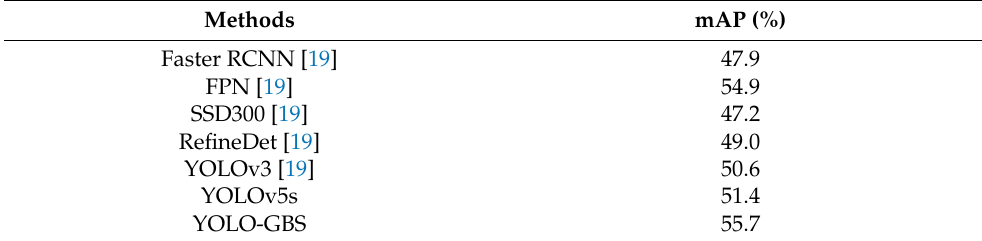
Table 3. Comparison of detection effects of different networks in IP102 dataset.